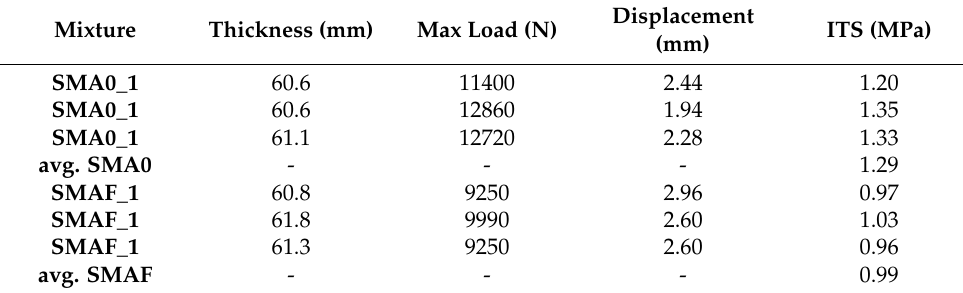
Table 6. Indirect tensile strength at 25 ◦ C